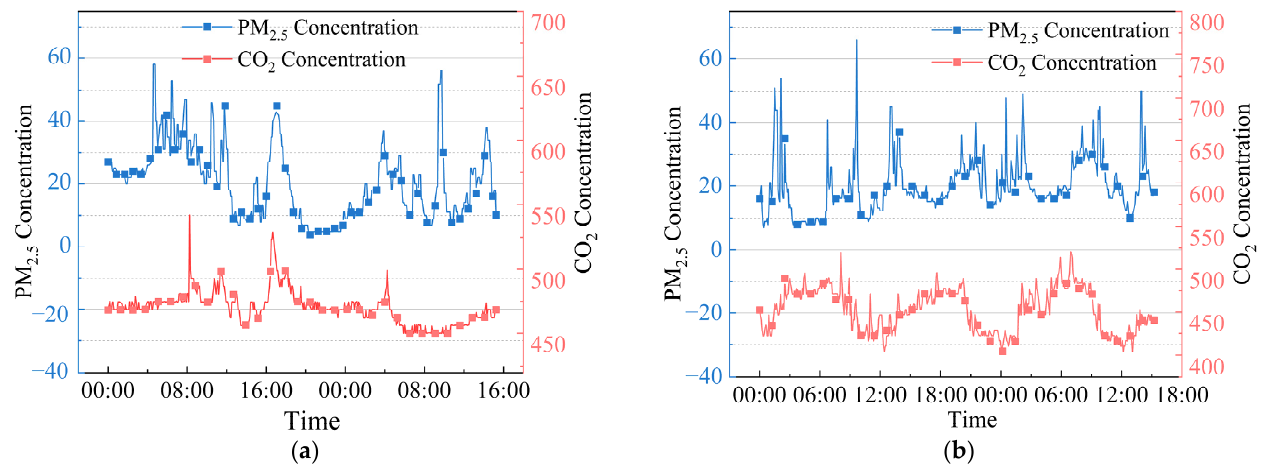
Figure 17. Distribution of CO 2 concentration and PM 2.5 concentration in indoor air quality. ( a ) Win- ter; and ( b ) summer.